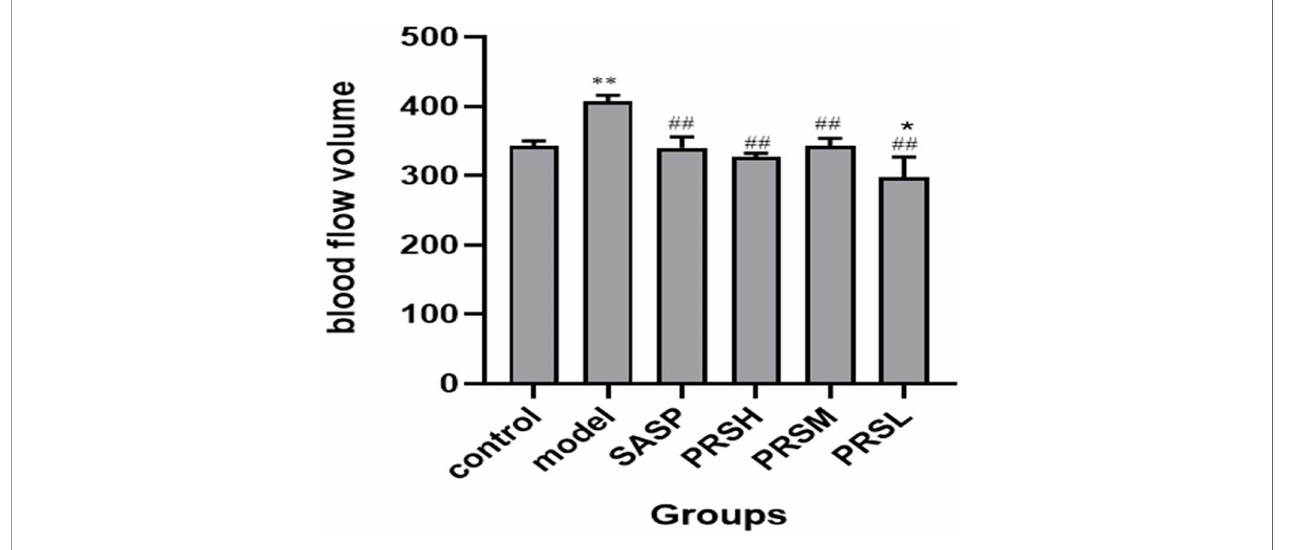
FIGURE 5 | Blood fl ow volume of each group of rat. Data are presented as means ± SD (n= 6 per group). ## p < 0.01 vs the model group on the same day; *p < 0.05 and **p < 0.01 vs the control group.